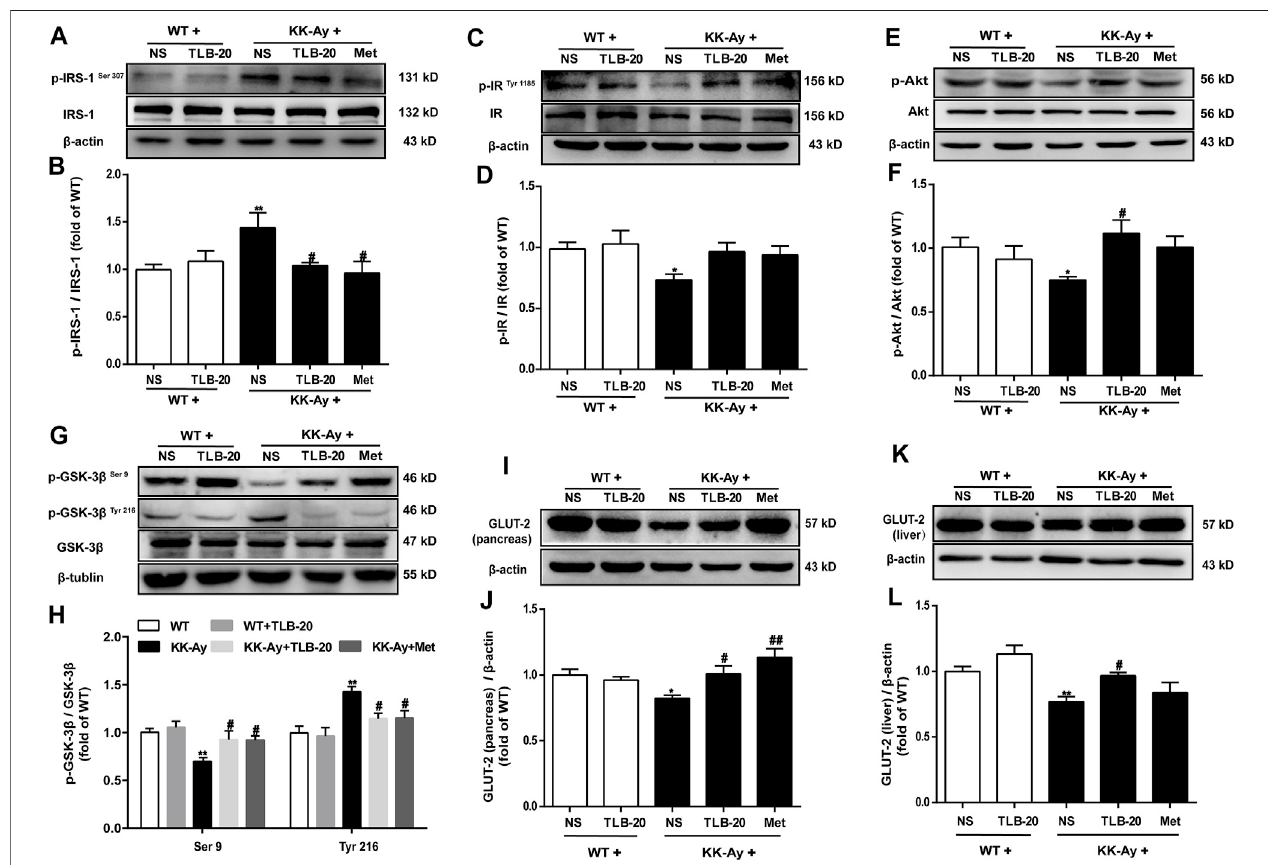
FIGURE8 | TLBattenuatedinsulinresistanceinKK-Aymicebyregulatingabnormalinsulinsignalingtransductionpathway. (A) Representativebandsofp-IRS-1 Ser307 in the pancreas. (B) Quanti fi cation of p-IRS-1 Ser 307 phosphorylation level in the pancreas. (C) Representative bands of p-IR Tyr 1185 in the pancreas. (D) Quanti fi cation of p-IR Tyr 1185 phosphorylation level in the pancreas. (E) Representative bands of p-Akt in the pancreas. (F) Quanti fi cation of p-Akt phosphorylation level in the pancreas. (G) Representativebandsofp-GSK-3 β Ser9 andp-GSK-3 β Tyr216 inthepancreas. (H) Quanti fi cationofp-GSK-3 β Ser9 andp-GSK-3 β Tyr216 phosphorylationlevelsinthe pancreas. (I) Representativebands ofGLUT-2inthe pancreas. (J) Quanti fi cationofGLUT-2protein expressioninthe pancreas. (K) Representative bandsofGLUT-2inthe liver. (L) Quanti fi cation of GLUT-2 protein expression in the liver. *p < .05, **p < .01 vs. WT group; # p < .05, ## p < .01 vs. KK-Ay group; n = 4-5 per group, mean ± SEM.